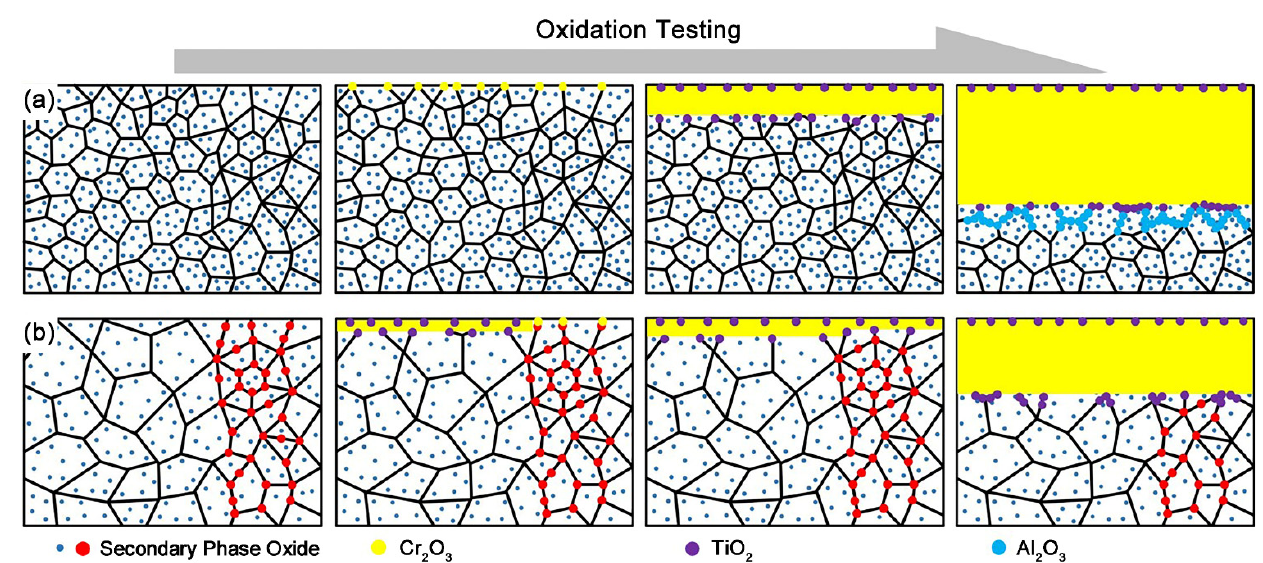
Figure 9. Schematic diagram of chromia scale formation on the surface of ( a ) S1 and ( b )